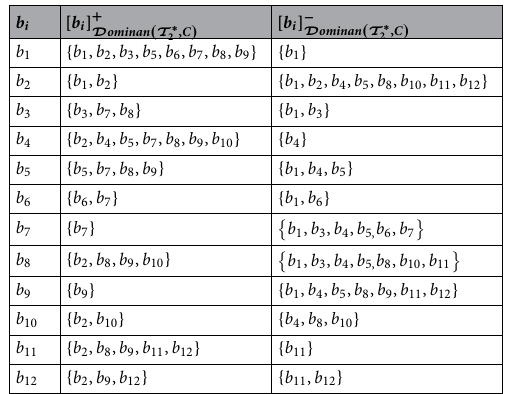
Table 3. Dominating classes [ b i ] + D ominan ( T ∗